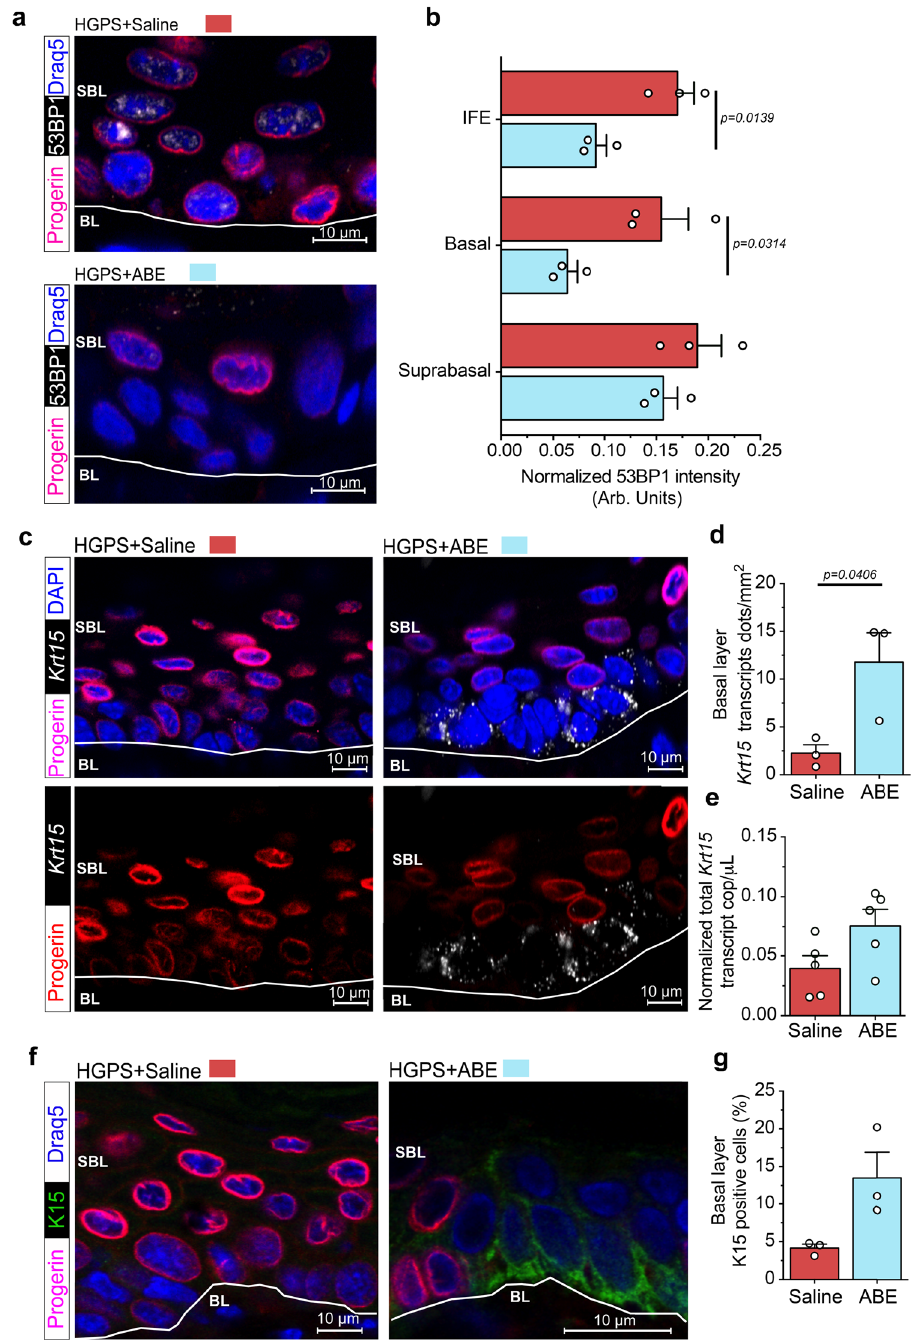
Fig. 5 Reduced accumulation of DNA damage and increased expression of Krt15 in clusters of cells without progerin expression. a Colocalization staining of progerin and 53BP1 in LF-ABE and saline-treated HGPS mouse skin four weeks post-injection. b In the IFE and the basal layer of LF-ABE treated skin ( n = 3 biologically independent samples) in comparison to saline-treated controls ( n = 3 biologically independent samples), a reduction in 53BP1 intensity was observed in progerin negative clusters, in the IFE ( p = 0.0139) and basal layer ( p = 0.0314) along with a reductive trend of 53BP1 accumulation in the suprabasal layer of the skin (53BP1 intensity normalized to DAPI intensity, Arbitrary Units = Arb. Units). c Krt15 in situ hybridization colocalized with progerin protein staining in LF-ABE and saline-treated HGPS mouse skin. d Increased Krt15 transcripts ( p = 0.0104) in skin upon LF-ABE treatment ( n = 3 biologically independent samples) in comparison to saline-treated controls ( n = 3 biologically independent samples) four weeks post- injection. e Absolute quanti fi cation of Krt15 transcripts by ddPCR in LF-ABE ( n = 5 biologically independent samples) and ( n = 5 biologically independent samples) saline-treated mouse skin. The fi rst cell layer above the white line is de fi ned as basal layer (BL). f , g Colocalization staining of progerin and keratin-15 (K15) proteins in LF-ABE ( n = 3 biologically independent samples) and saline-treated ( n = 3 biologically independent samples) HGPS mouse skin four weeks post-injection with quanti fi cation graph. Scale bars: a, c, d = 10 μ m. LF-ABE treated samples are depicted in blue, saline-treated samples are depicted in red. Data are represented as mean values + / − SEM. b , d P values between samples were calculated by two-tailed unpaired t test, 95% CI. For ( b , d , e , g ) data are provided as a Source Data fi le.